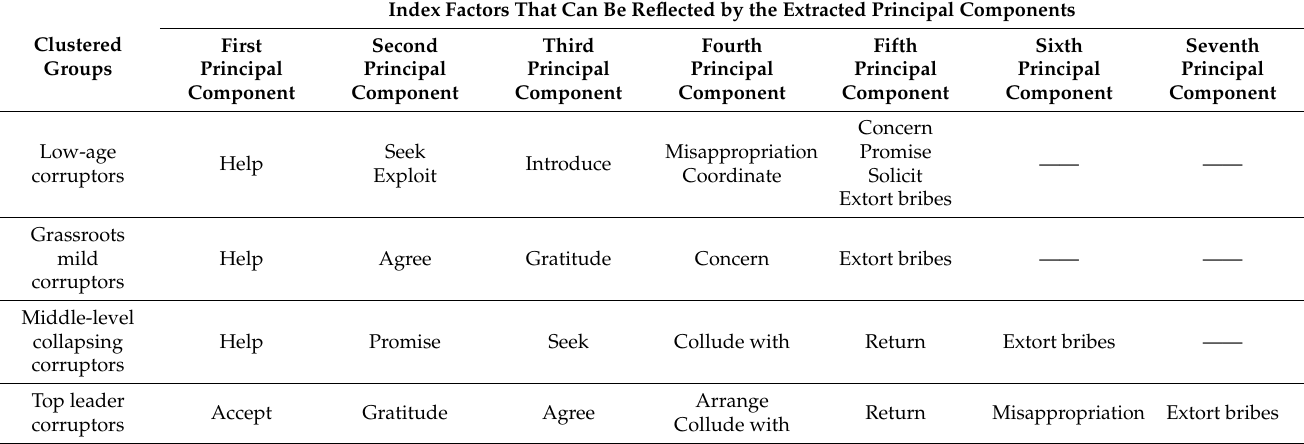
Table 6. Results of principal component analysis of corruption